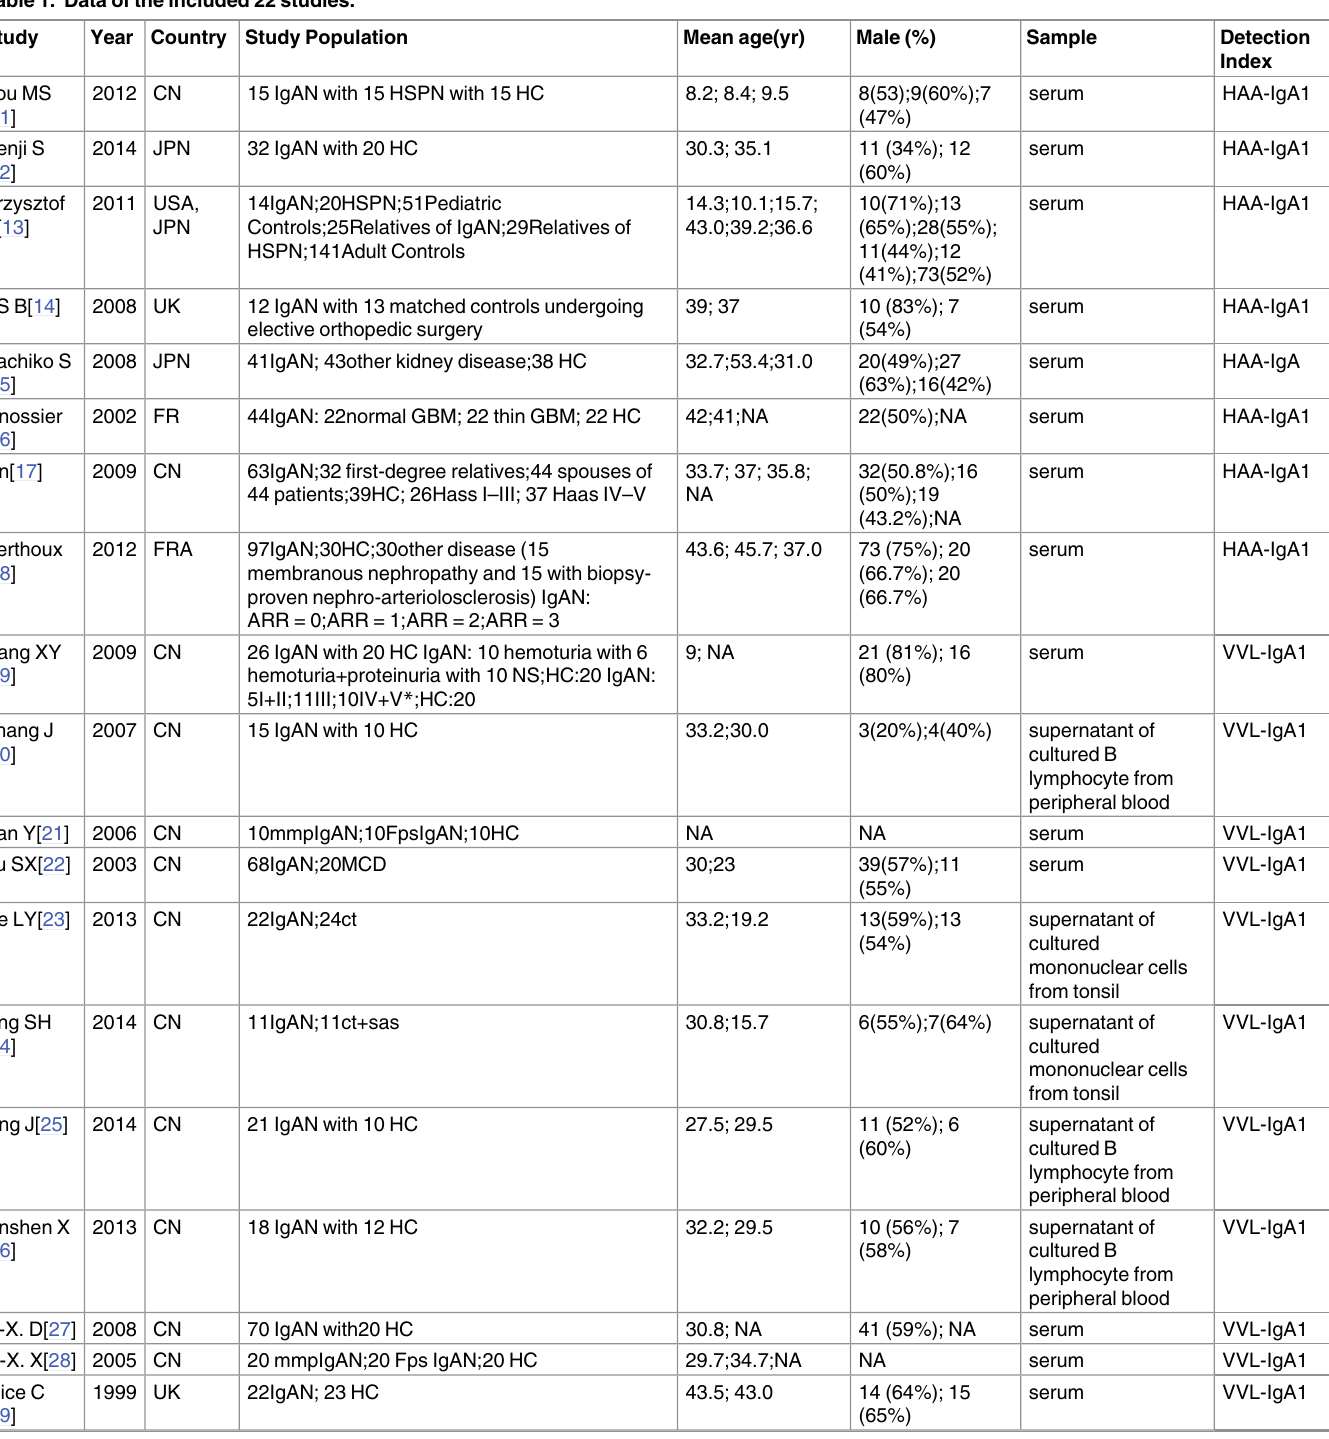
Table 1. Data of the included 22 studies.